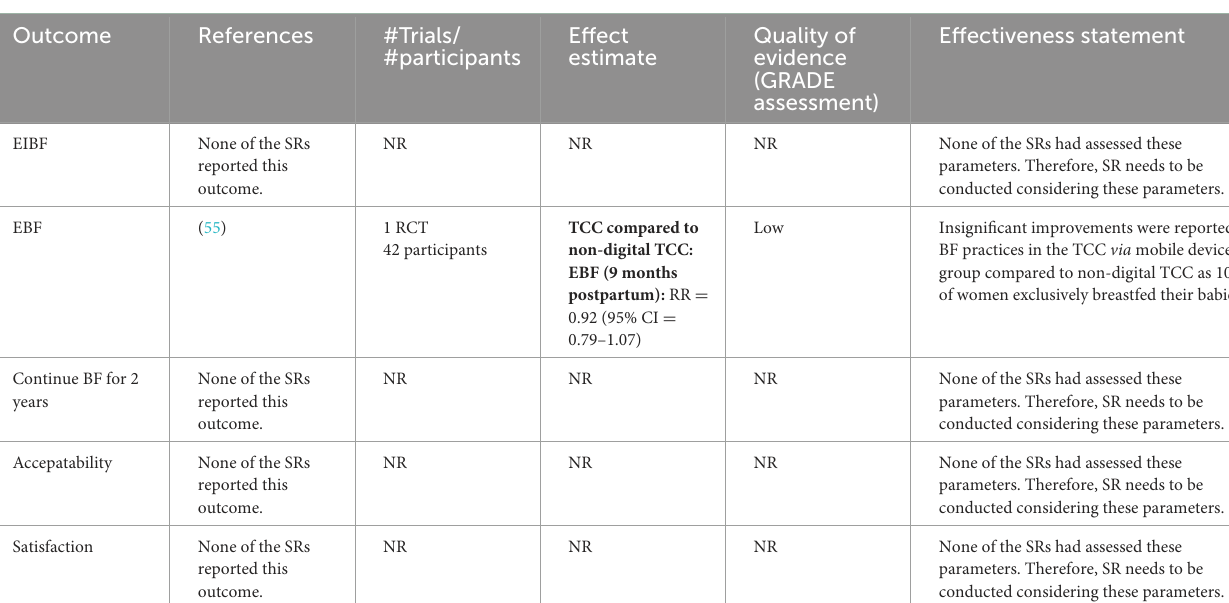
TABLE 3 Findings of included